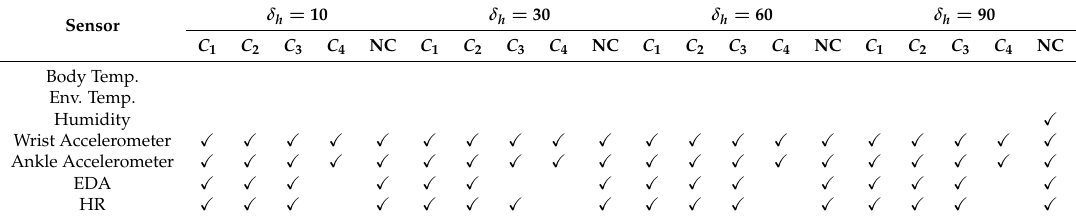
Table 3. Sensors included in the normalized model.